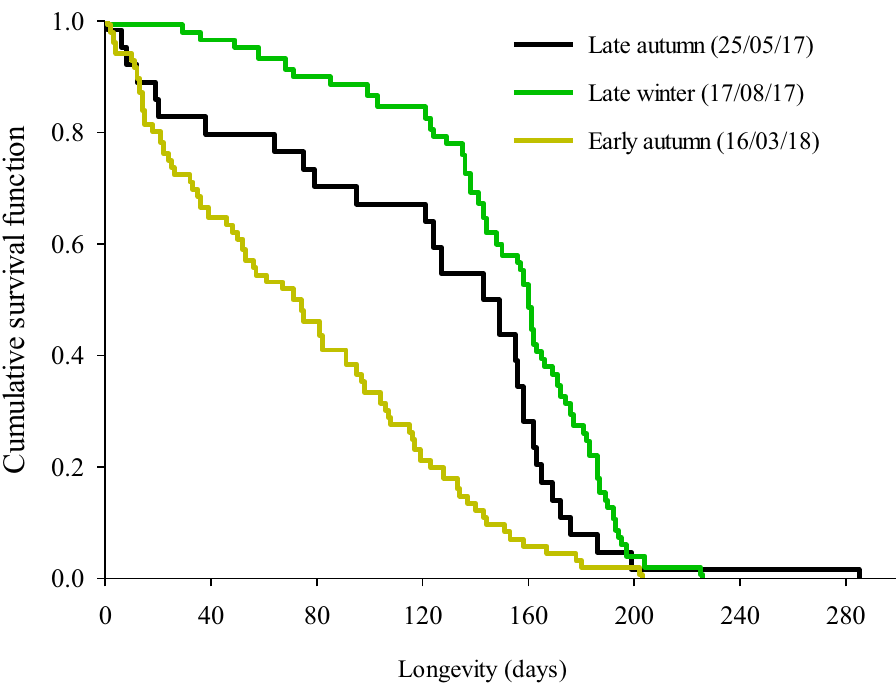
Figure 2. Cumulative survival curves of three cohorts of adult female Bactrocera tryoni that emerged in the laboratory from field infested fruit collected during different seasons in 2017–18 from a site in subtropical Australia. In the laboratory flies were held at 27 °C constant temperature and had ad libitum access to water and food.